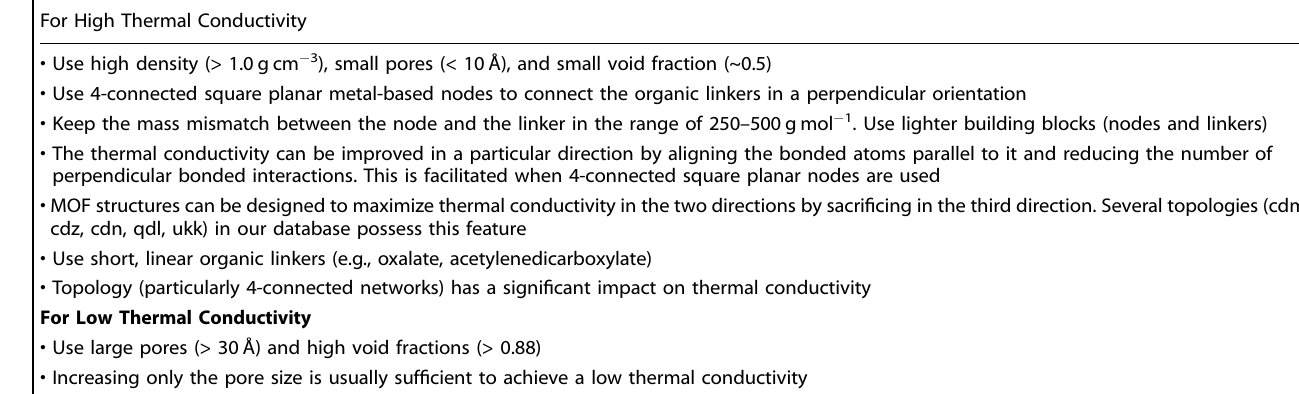
Table 2. A summary of the strategies for designing MOFs with low/high thermal conductivities. For High Thermal